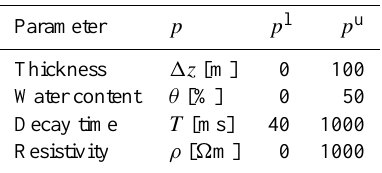
Table 1. Lower and upper parameter bounds for the individual